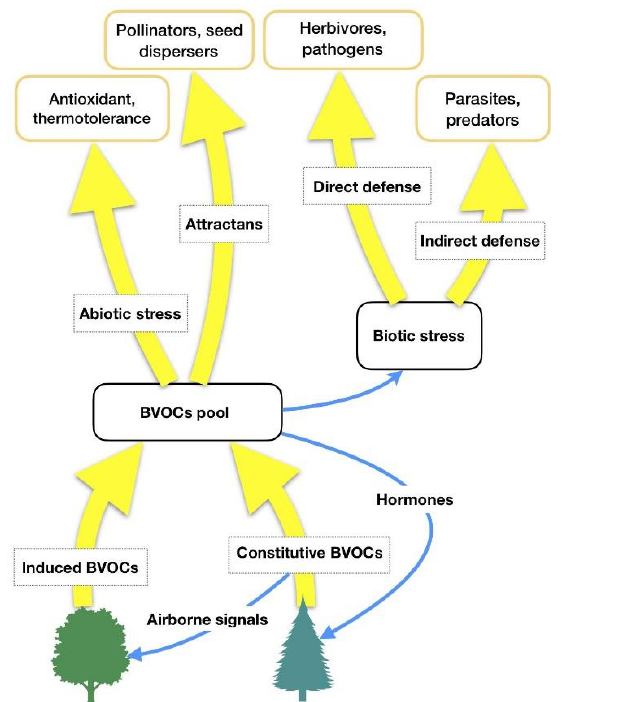
Figure 1. BVOCs’ functions in relation to biotic and abiotic stresses. Adapted from Laothawornkitkul et al. (2009) [8].